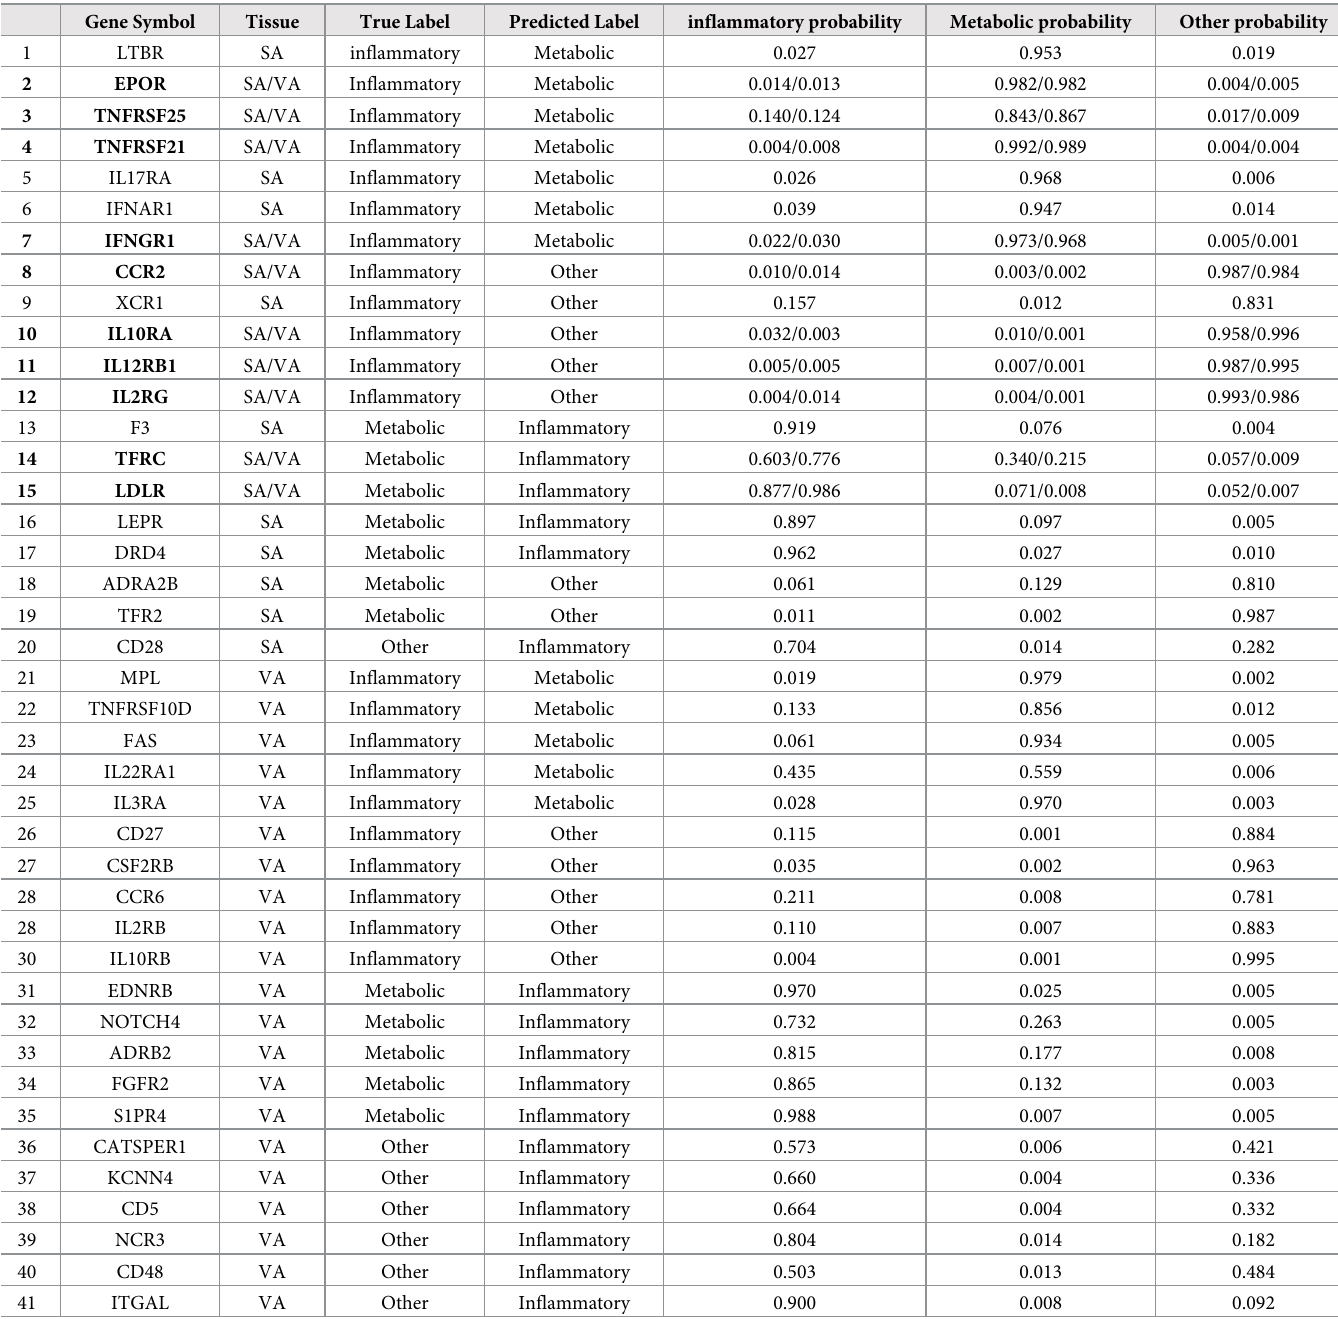
Table 2. Misclassified receptors in subcutaneous and visceral adipose with their true/predicted labels and